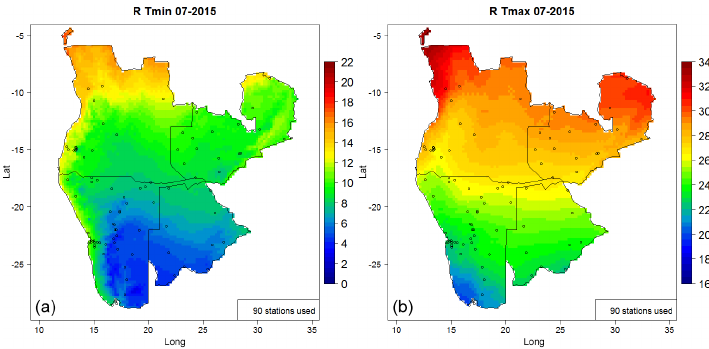
Figure 5. Temperature map of July 2015 on basis of the linear regression. (a) T min , (b) T max . Unit: ◦